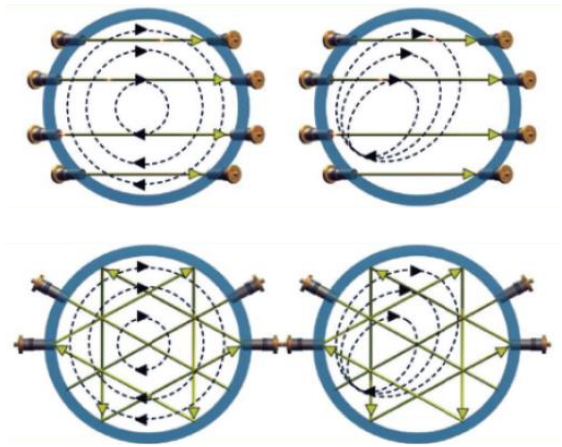
Fig. 5. Various configurations of ultrasonic flow meters with shown signal paths for compensation of symmetric and asymmetric swirls during measurement in natural gas pipelines